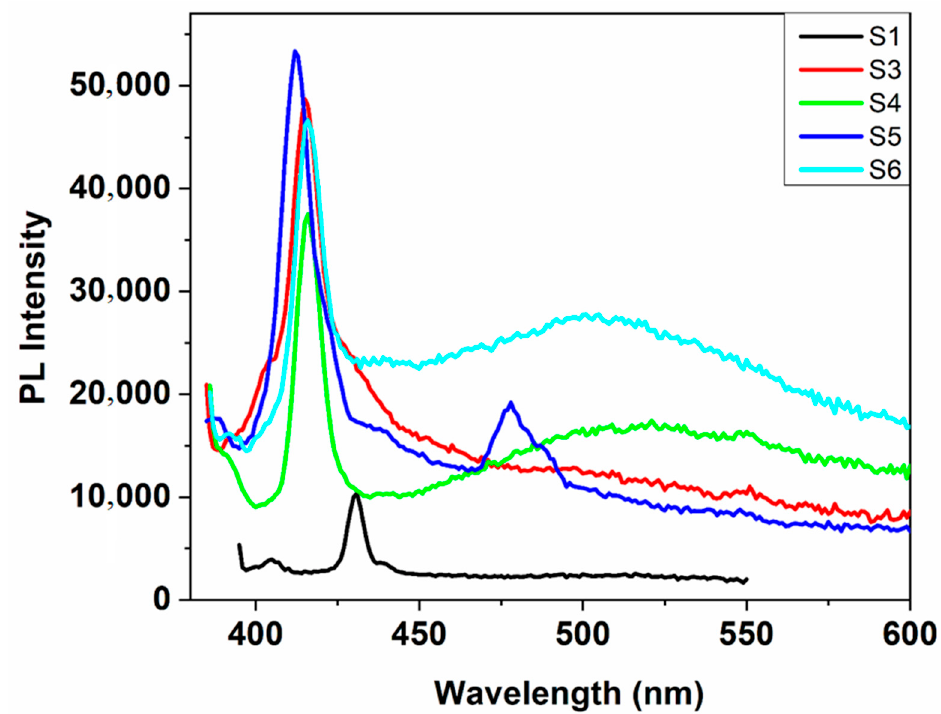
Figure 7. Fluorescence spectra of pure ZnO and ZnO:MoO 3 nanostructures, recorded in 1-propanol solution, at room temperature.